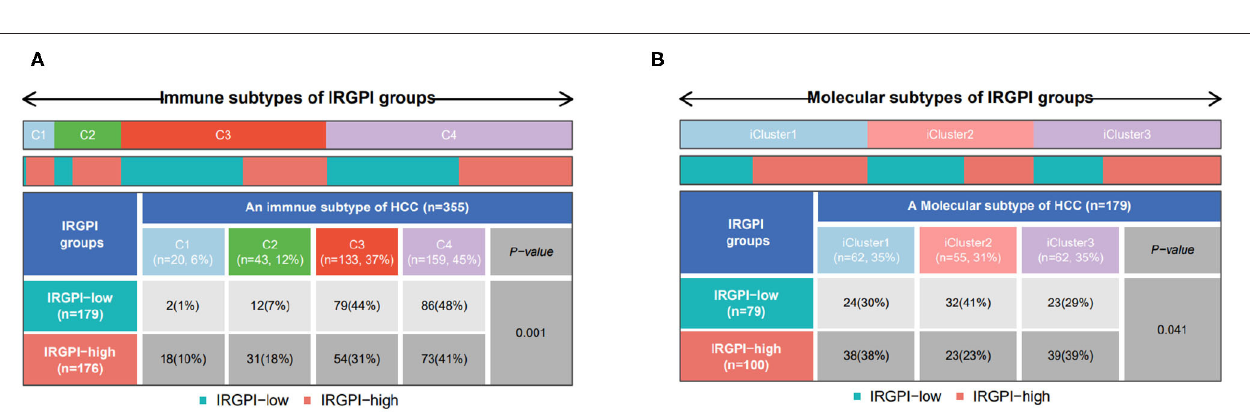
FIGURE 7 | (A) Patient proportions between IRGPI groups among TCGA immune subtypes, and (B) molecular